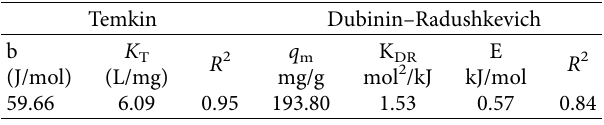
Table 4: Temkin and Dubinin–Radushkevich isotherm parameters